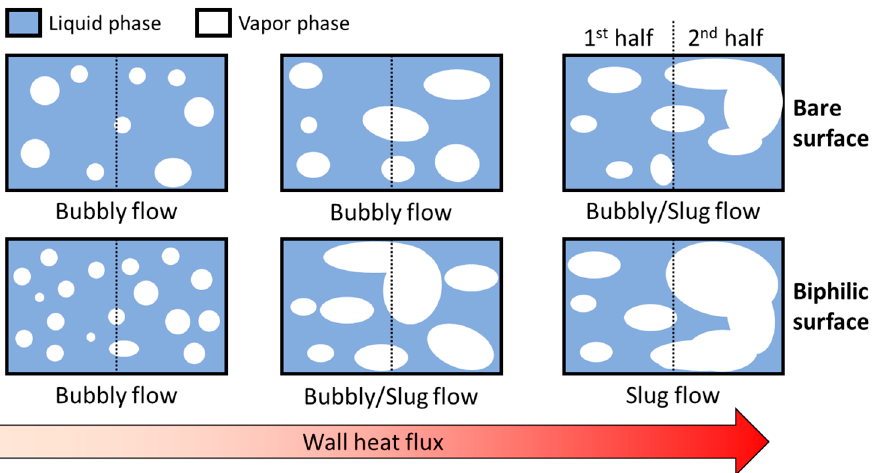
Figure 6. Obtained heat transfer coefficients for mass flux of 80 kg m − 2 s − 1 ( a ) the 1st half of the microchannel ( b ) the 2nd half of the microchannel.